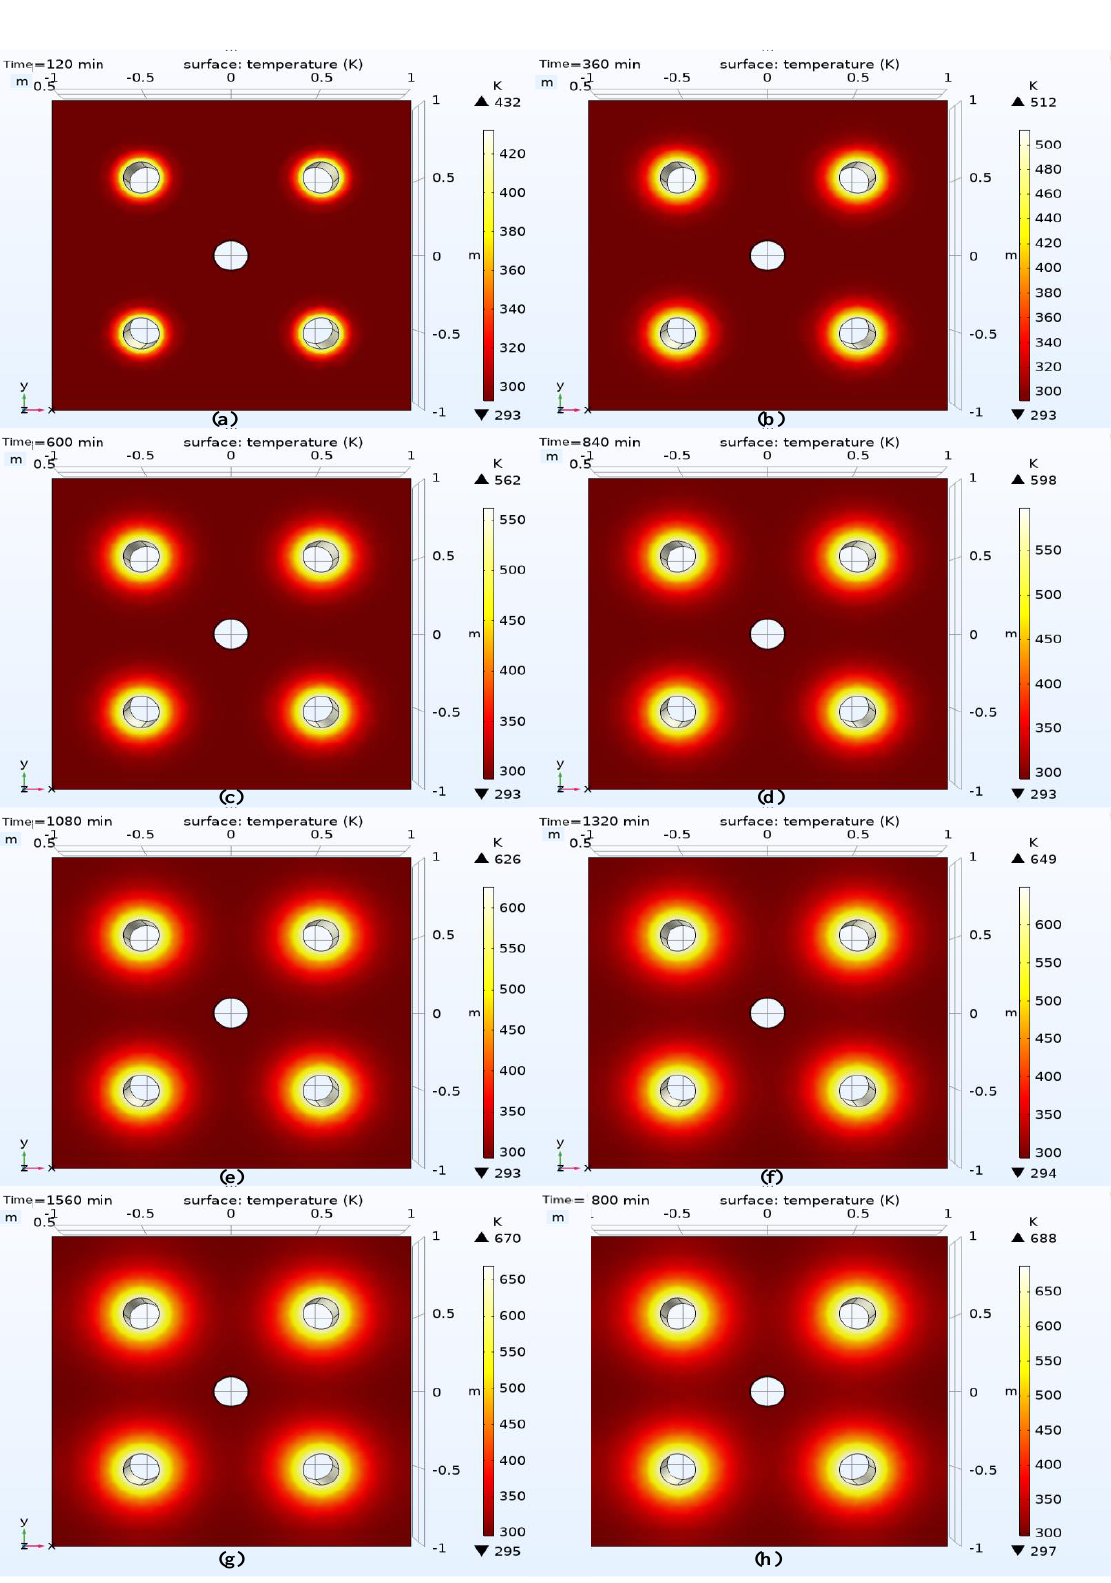
Figure 9. Variation of soil temperature with time under the coupling of heat transfer in porous media and Darcy velocity field. Subfigures ( a – h ) show the temperature field distribution of porous media every 4 h after the second hour of simulation. The temperature corresponding to different colors is given in the legend.